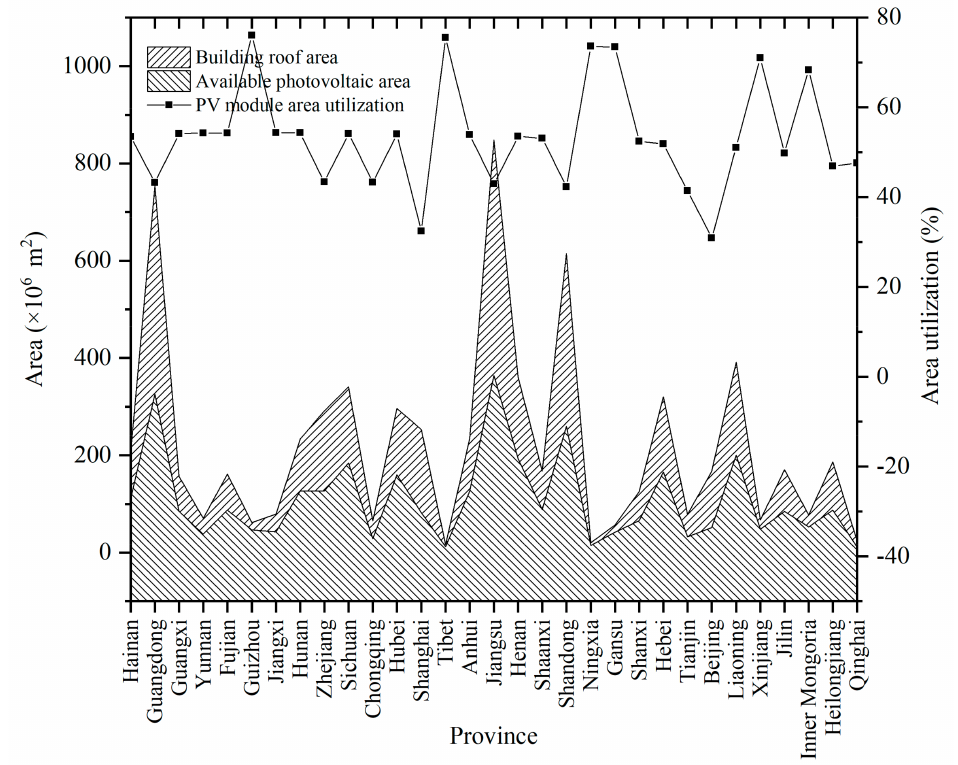
Figure 9. Areas of photovoltaic power generation in cities in different provinces in